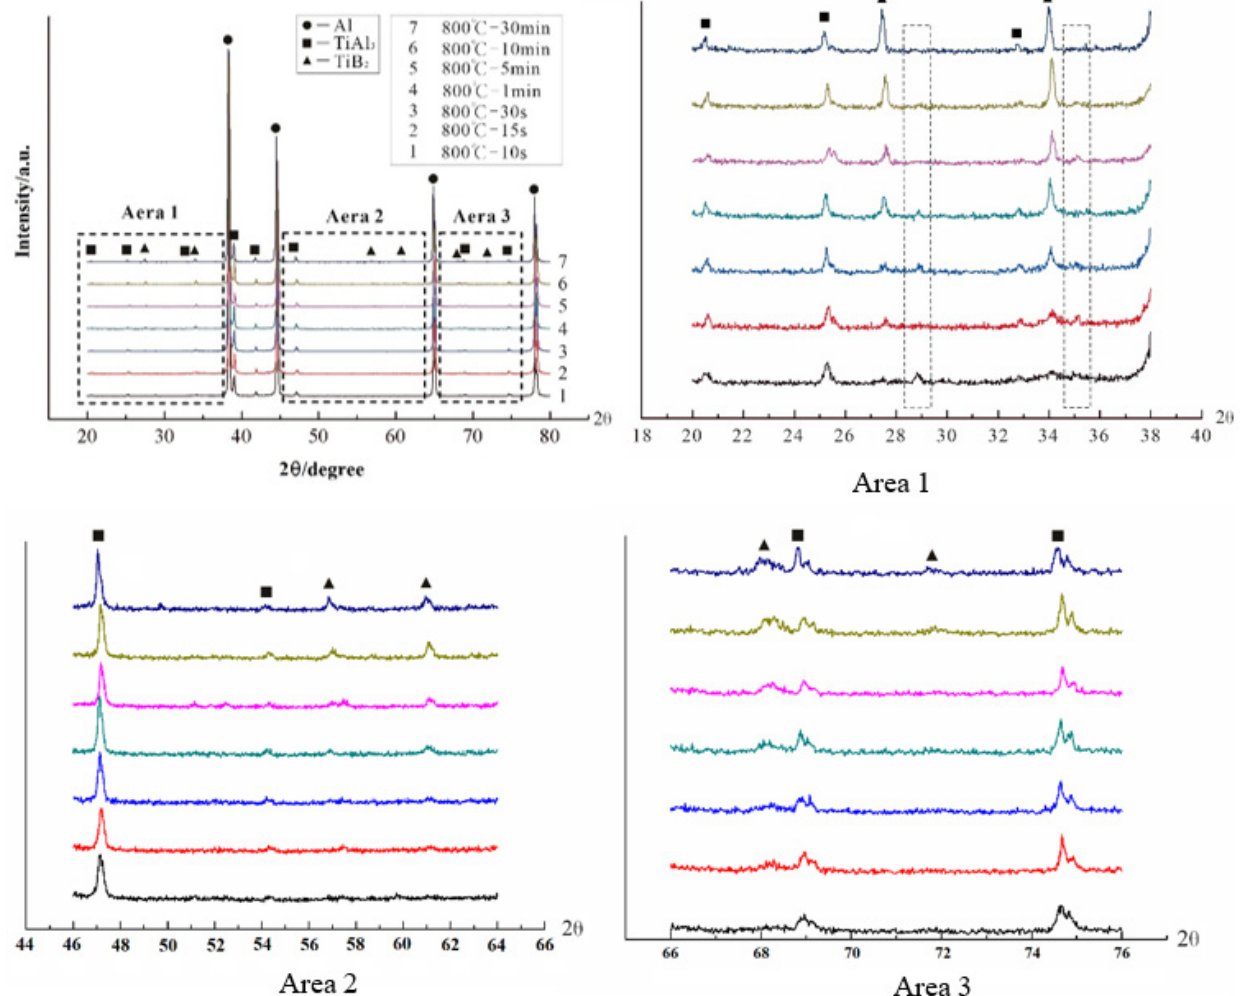
Figure 2. XRD pattern of Al–Ti–B Master Alloy prepared by the halide salt route at 800 °C for different reaction times.